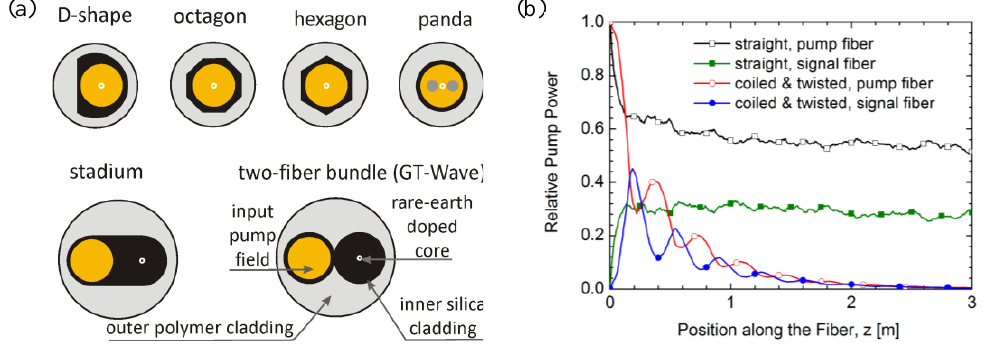
Fig. 1 (a) Examples of double-clad fiber cross sections of the inner cladding with broken circular symmetry for enhancement of pump absorption; yellow part schematically represent possible input pump distribution.